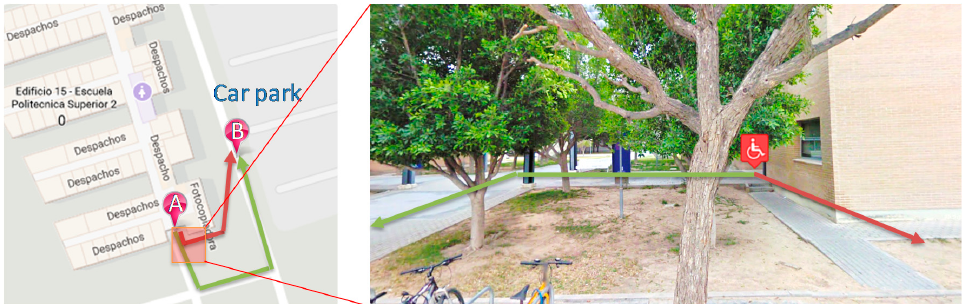
Figure 8. Example 1. Different routes detected due to movement disability.